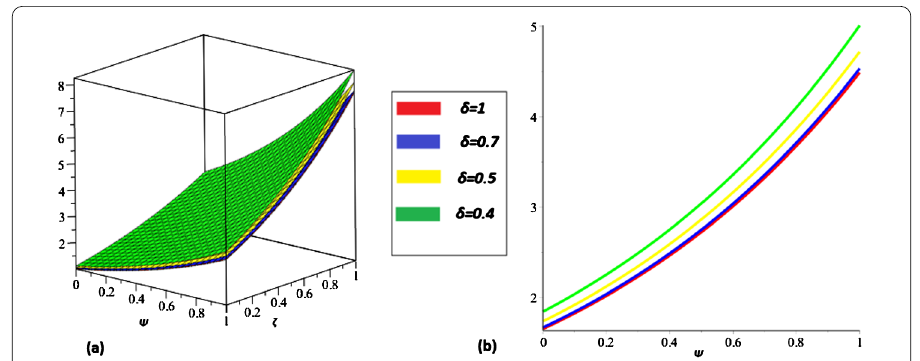
Figure 6 The ( a ) ETDM ν -solution of example 2 at different fractional orders of δ ( b ) ζ = 0.5